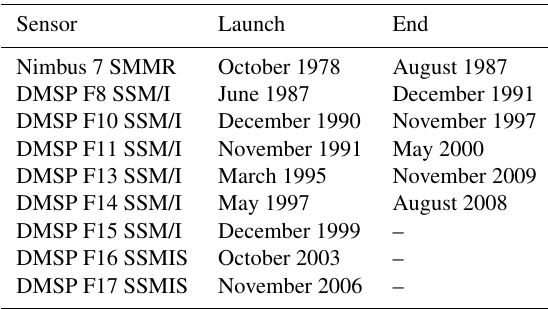
Table 1. The satellite missions carrying the SMMR, SSM/I, and SSMIS instrument and the periods they